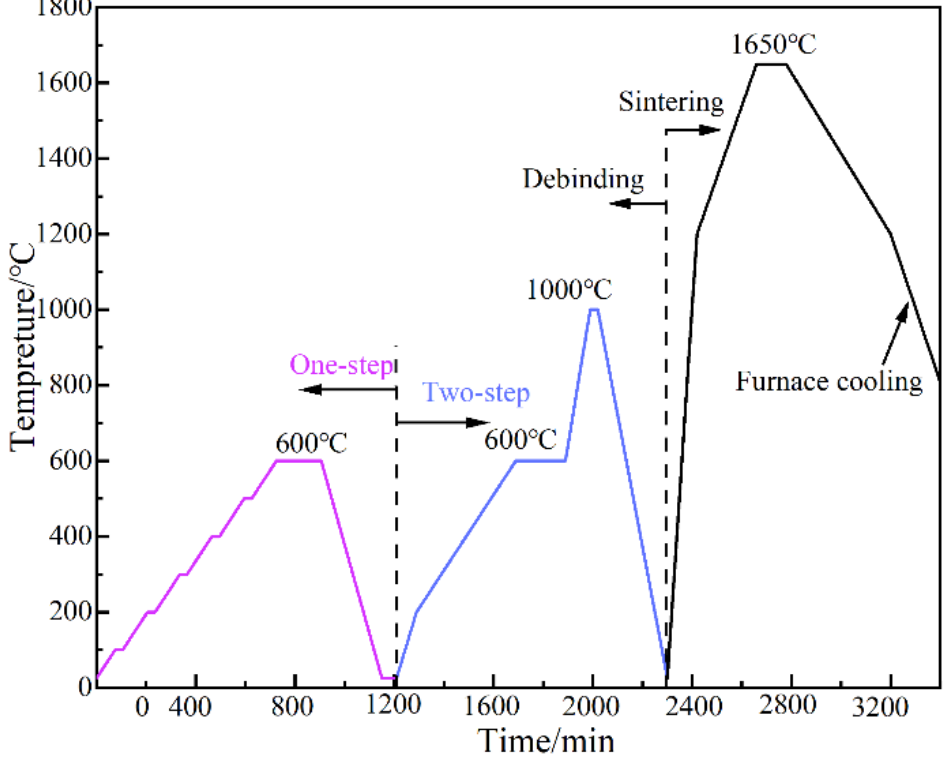
Figure 1. Degreasing and sintering process.